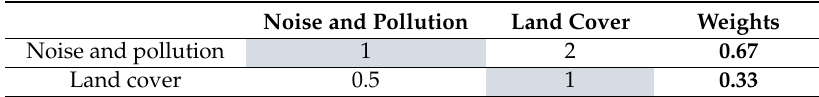
Table 8. Comparison matrix and significance weight of sub- criteria of environment.